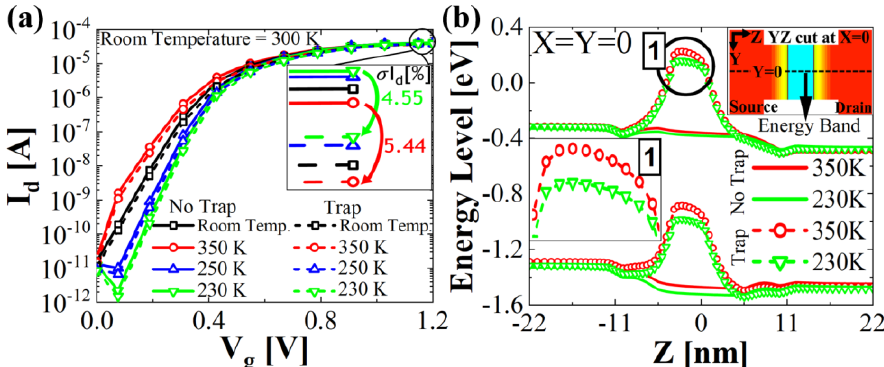
Figure 4. ( a ) I d − V g characteristics with different temperatures. ( b ) In the YZ plane cut, the energy band diagram at 230 K and 350 K with and without defect in the X = Y =0 μ m. The displacement defect is located at the worst position, as shown in Figure 3.